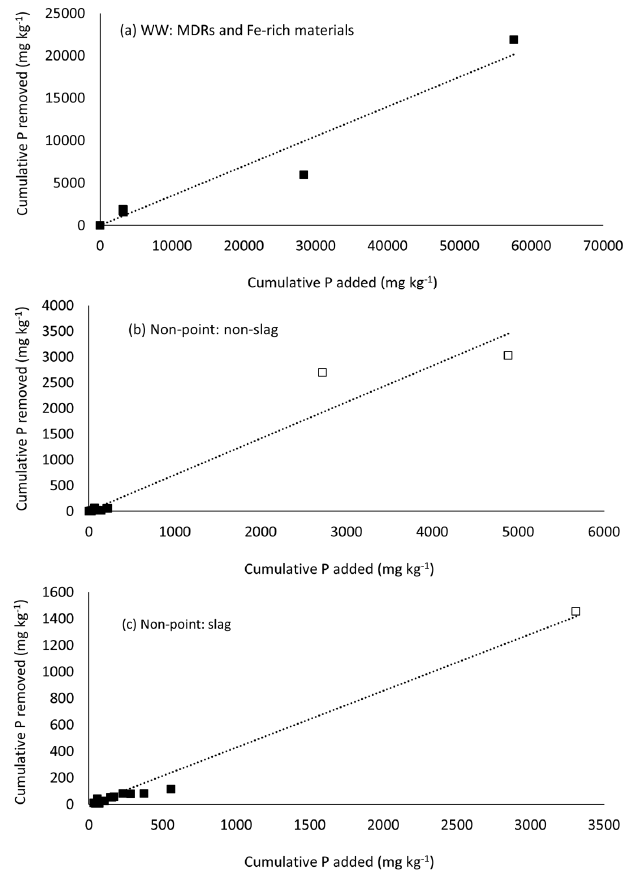
Figure 4. Cumulative P removed for studies with low dissolved P inflow concentrations and short retention time (RT), expressed as a function of cumulative P loading for the data listed in Table 1: ( a ) wastewater (WW) treated with mine drainage residuals (MDRs) and Fe ‐ rich materials; ( b ) non ‐ point source drainage water treated with non ‐ slag materials; and ( c ) non ‐ point drainage water treated with slag. Statistics are listed in Table 2. “Non ‐ point” refers to non ‐ point source drainage water. Open